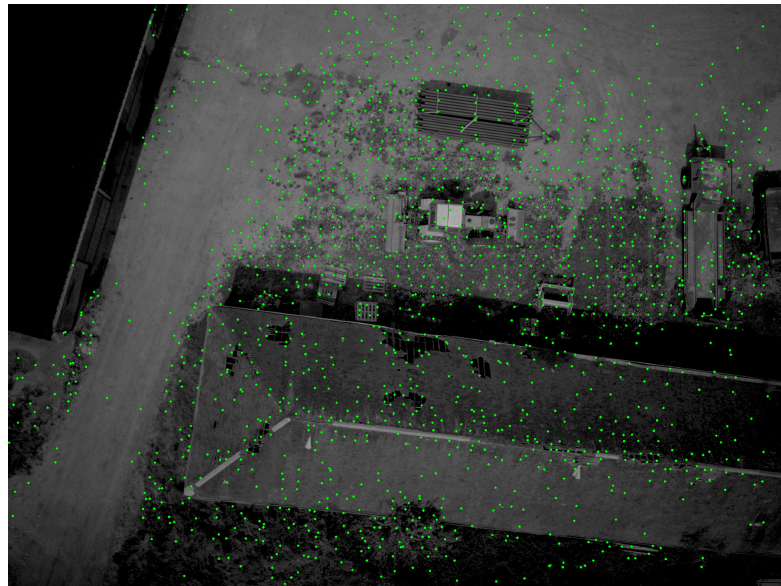
Figure 5. Uniform distribution of features over the image. The threshold intensity value of the detector is set to 7. This image is acquired with a low exposure time, but brightened artificially to clearly show the feature points. The size of the grid-adapted features is set to 100 × 100 blocks.